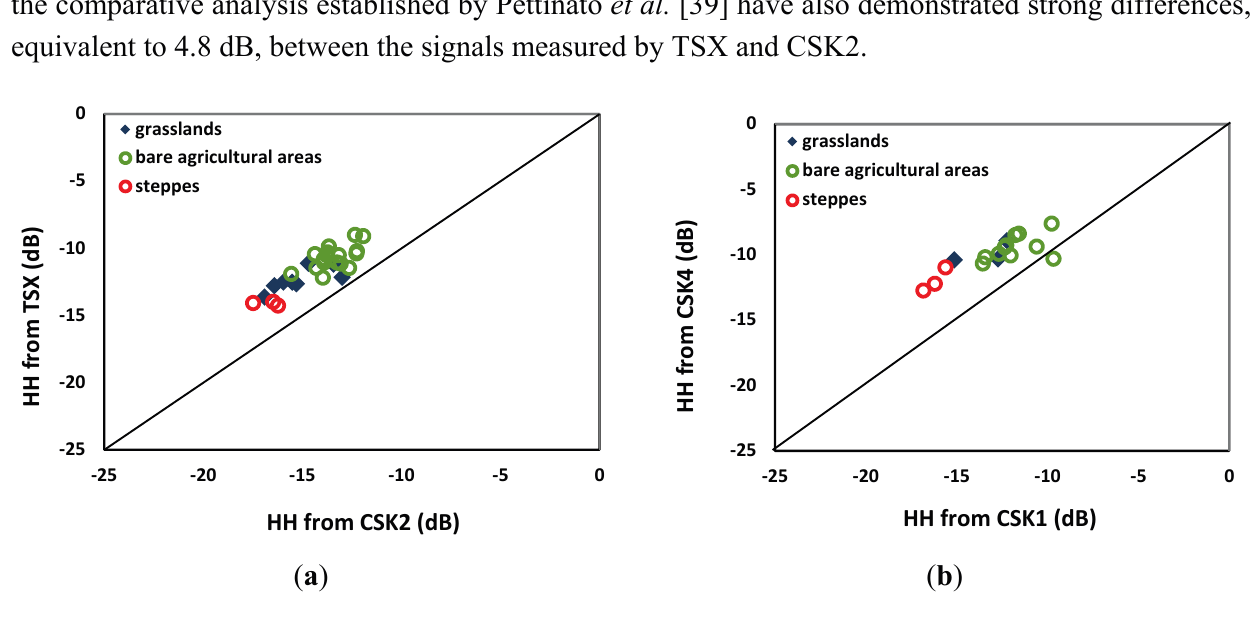
Figure 4. Inter-comparison between COSMO-SkyMed and TerraSAR-X data at HH polarization: ( a ) TSX and CSK2 at 36° and ( b ) CSK1 and CSK4 at 26°. Each point corresponds to one homogenous region of